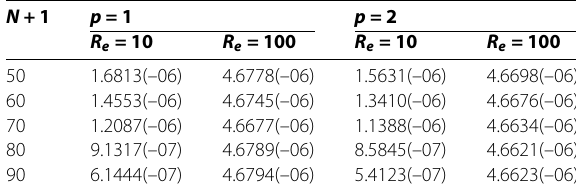
Table 17 Example 9: Maximum absolute errors at t = 1, k =